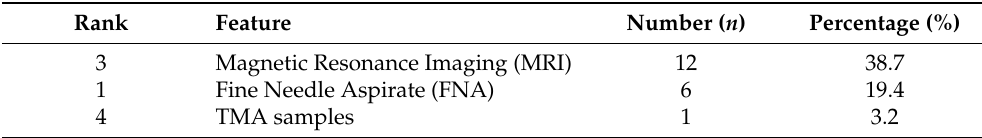
Table 5. Ranking of feature predictors used based on medical images information. n corresponds to the number of studies using each feature; % is n /31 × 100, 31 being the total of studies included in this review. Rank Feature Number ( n ) Percentage (%) 3 Magnetic Resonance Imaging